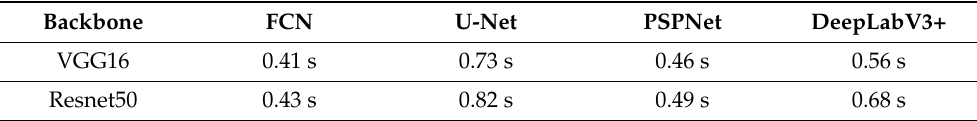
Table 6. Time consumption of a single image inference.